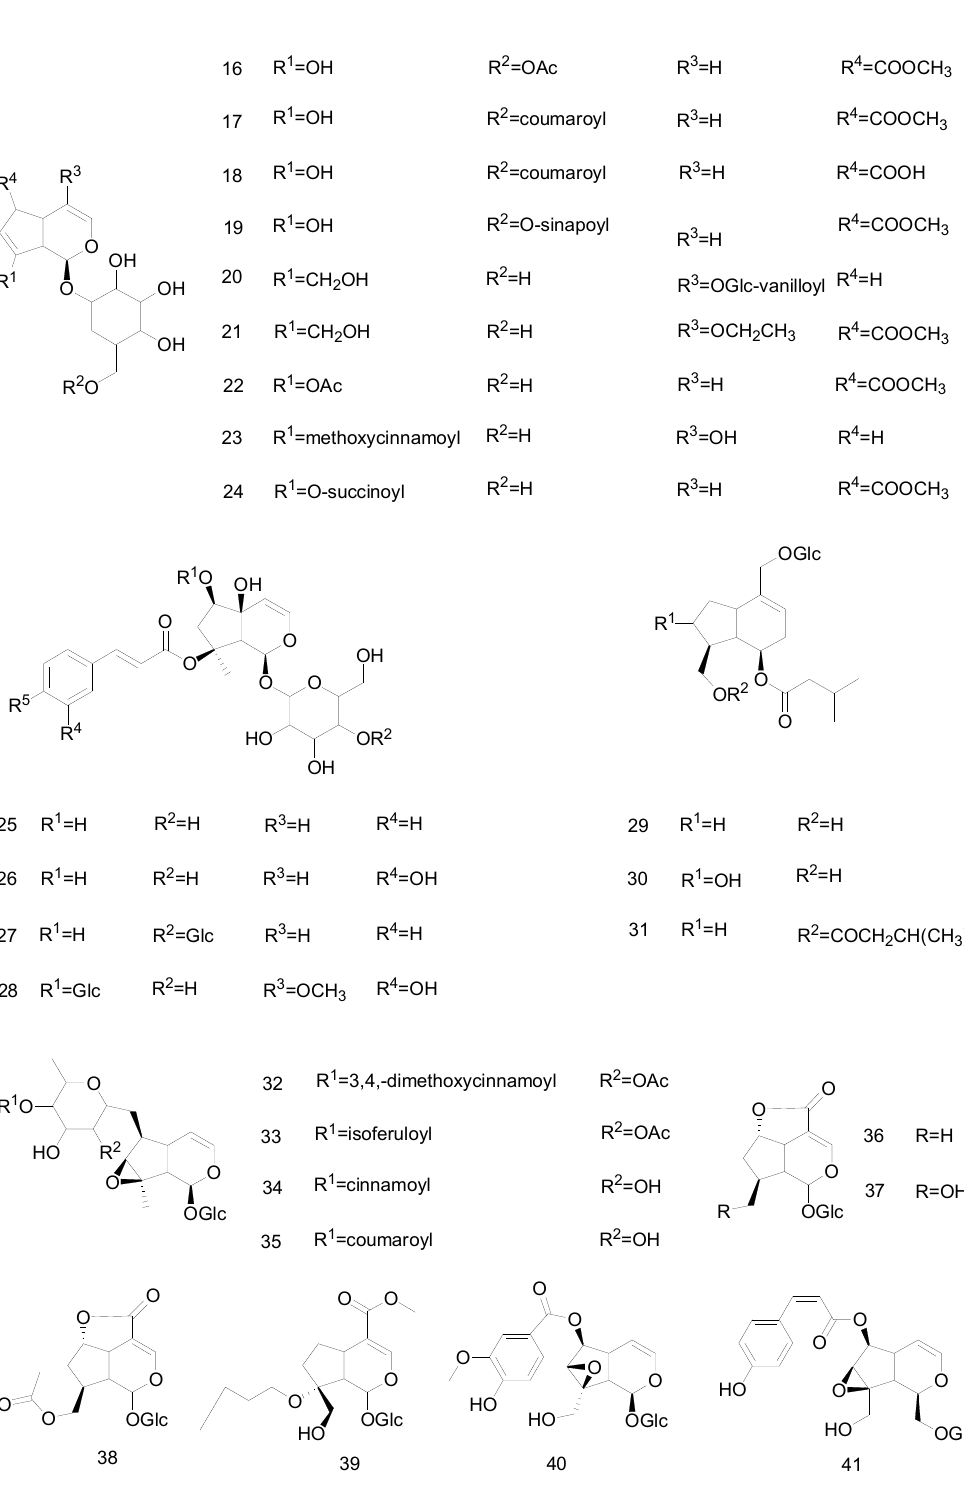
Figure 2. Chemical structures of iridoid glycosides.